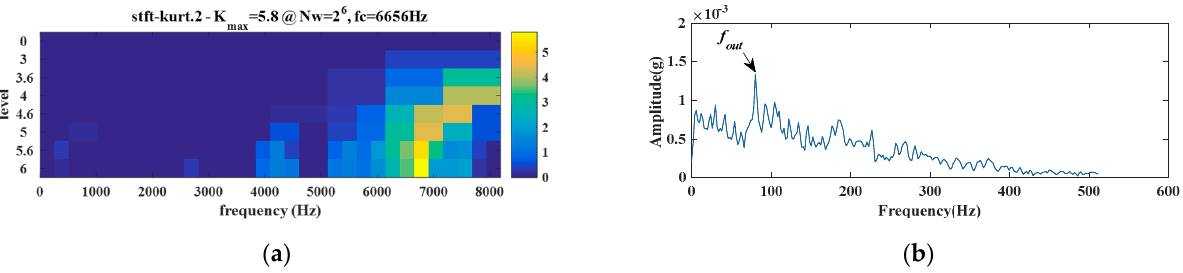
Figure 27. SK analysis results of the engineering fault signal: ( a ) kurtogram; ( b ) envelope spectrum of the filtered signal.